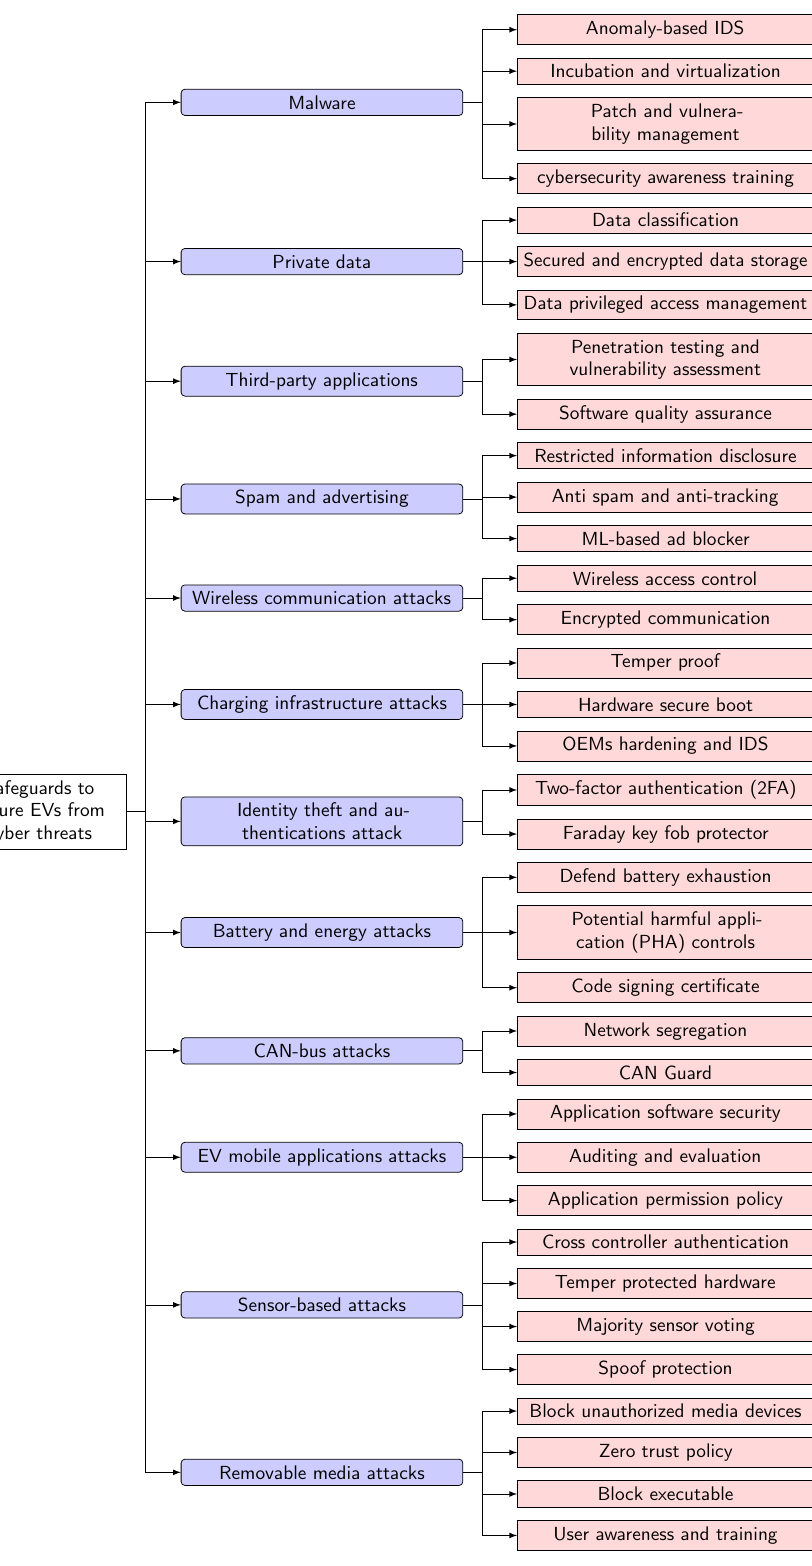
Figure 7. Defenses-to-Threats: third taxonomy that provides safeguards against cyber challenges to Figure 6. Defenses-to-threats: third taxonomy that provides safeguards against cyber threats to EVs.